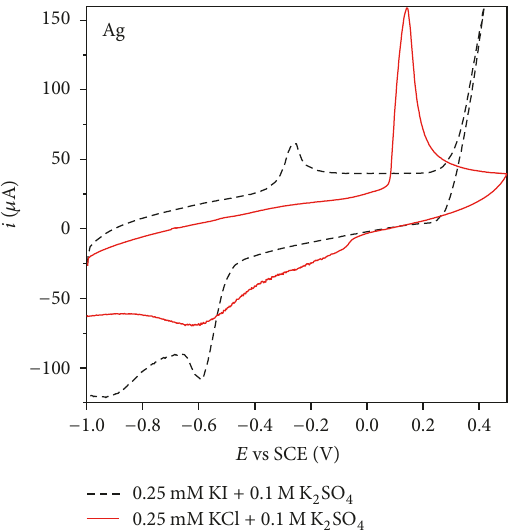
Figure 6: CVs of pure Ag catalyst in 0.25 mM KI (---) and 0.25 mM KCl (—) in 0.1M K 2 SO 4 as supporting electrolyte recorded at scan rate of 100mV s −1